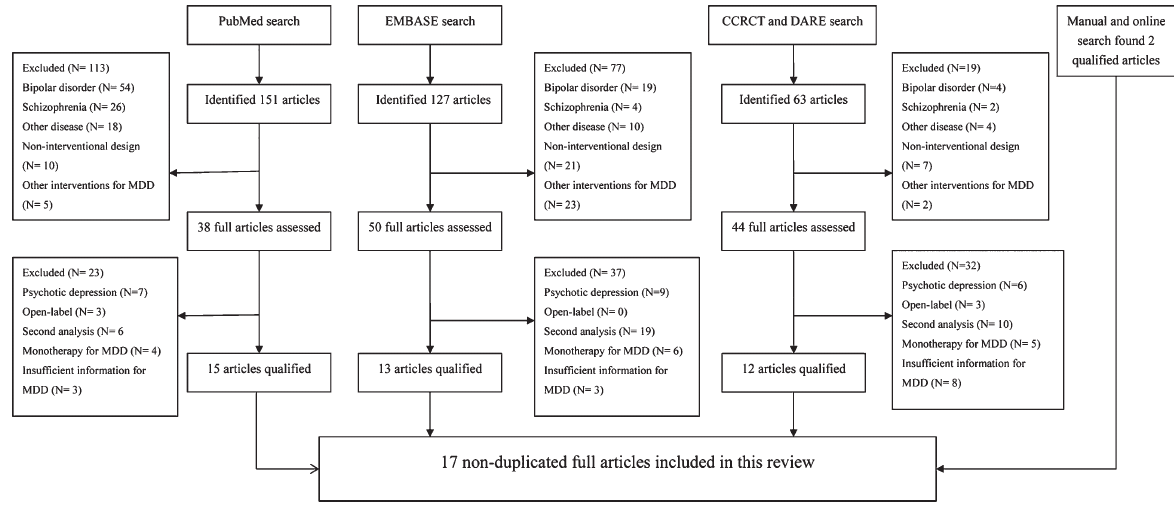
Figure 1. Flow chart of the literature search. The search was made with the terms ‘‘olanzapine’’, ‘‘aripiprazole’’, ‘‘risperidone’’, ‘‘quetiapine’’, ‘‘major depressive disorder’’, and ‘‘randomized controlled trial’’. EMBASE and other related databases were also searched with the same items produced through PubMed. CCRCT: Cochrane Central Register of Controlled Trials (to July 2012); DARE: Database of Abstracts of Reviews of Effects; MDD: major depression